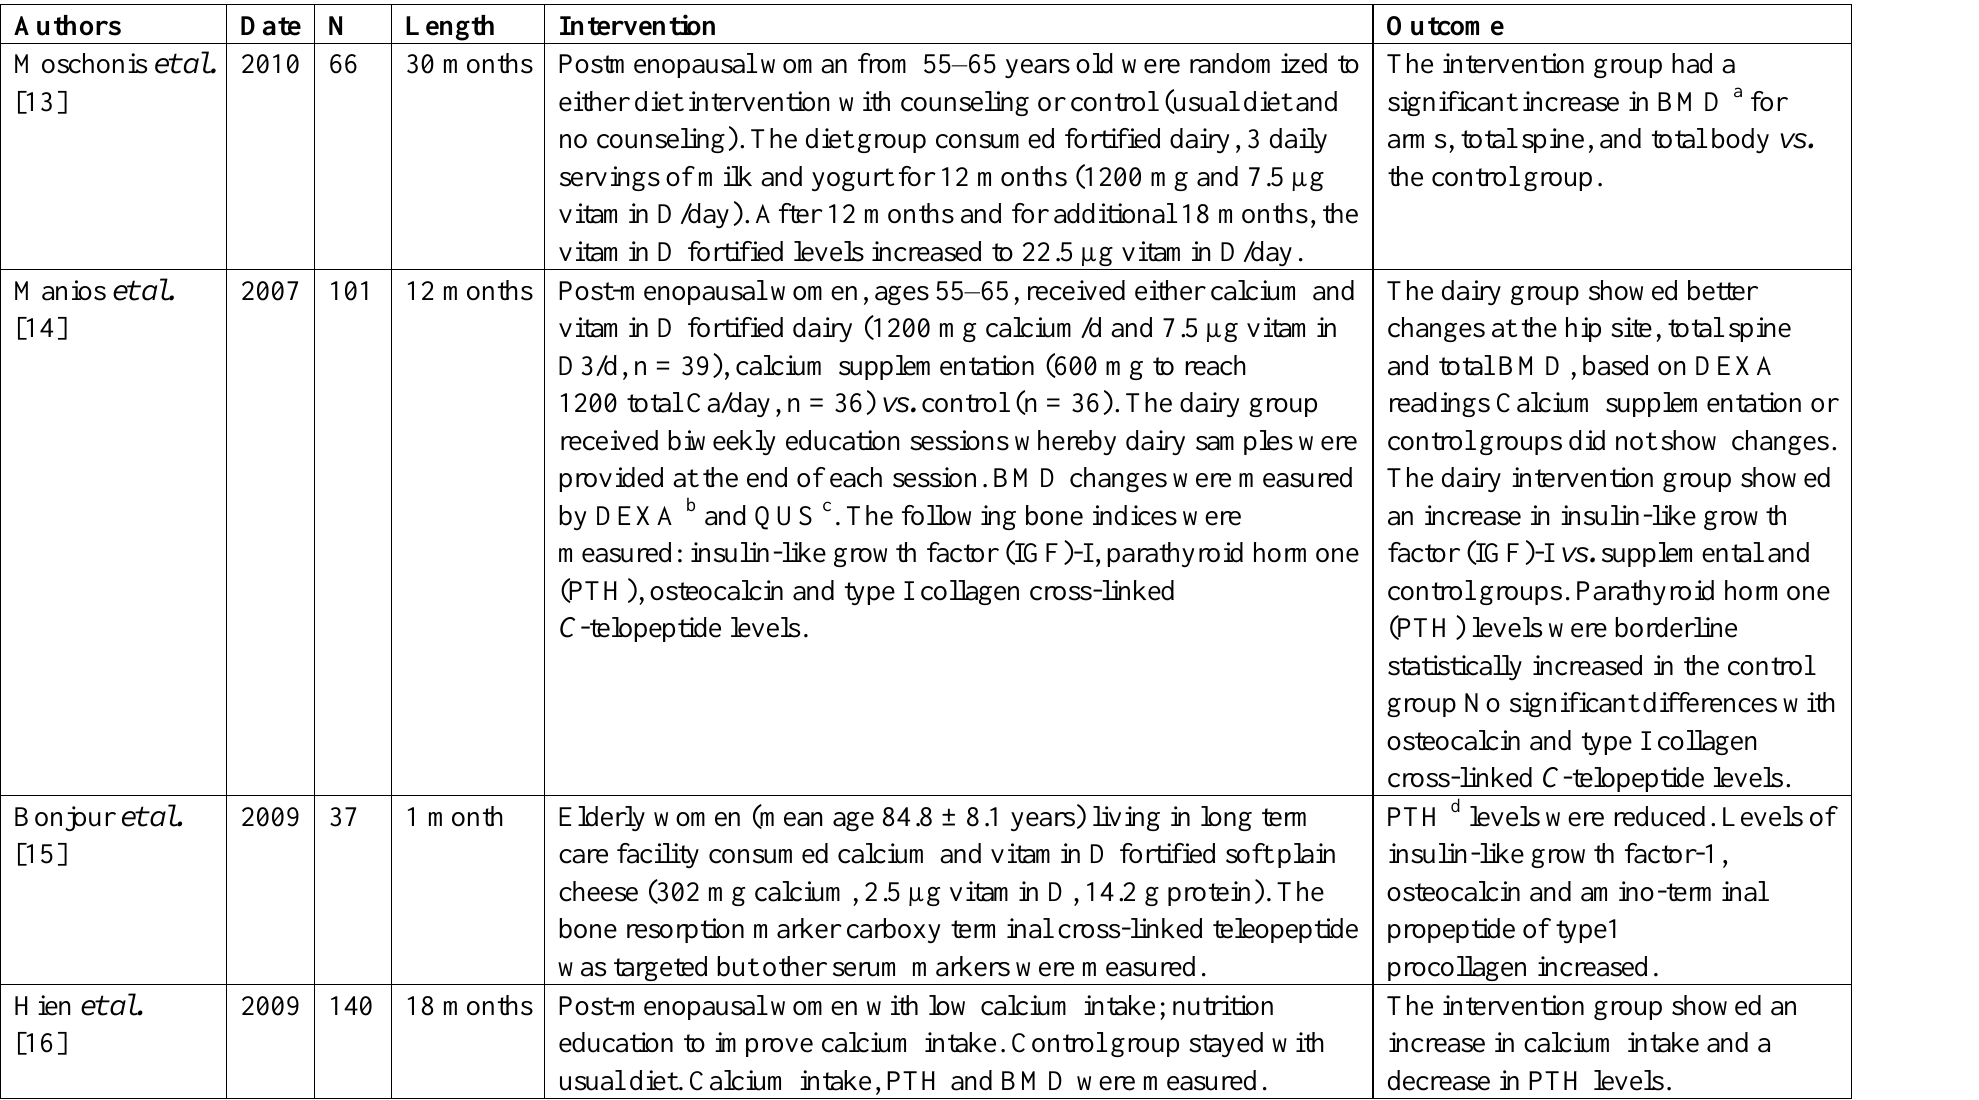
Table 1. Calcium and vitamin D interventions